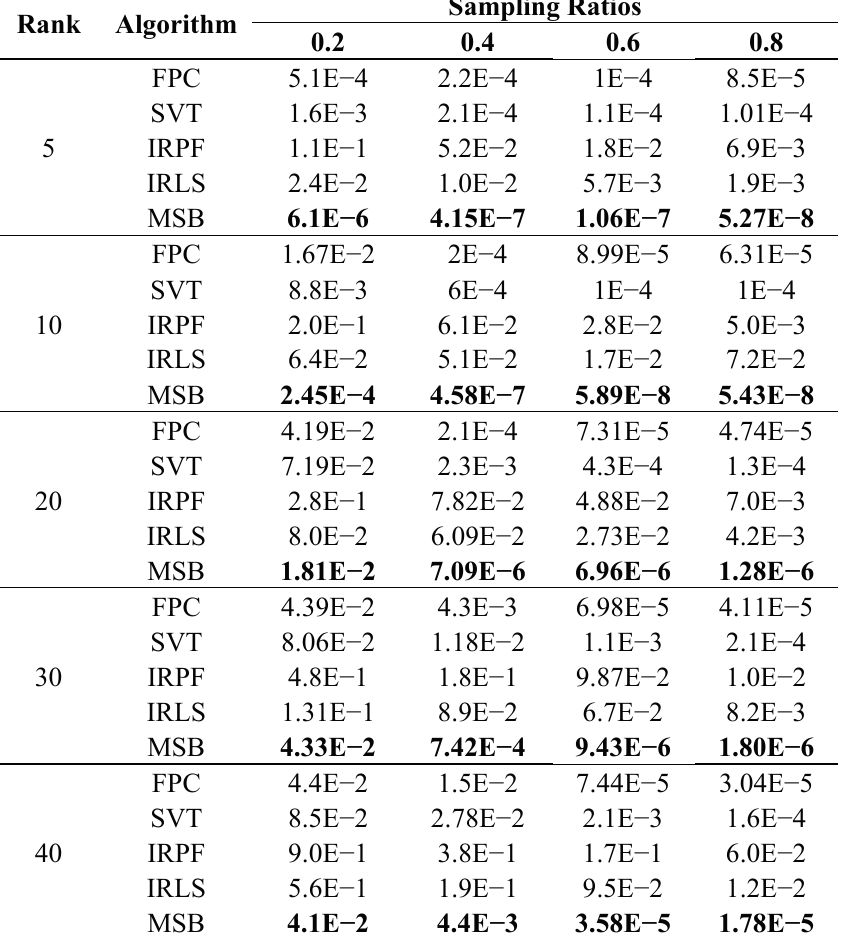
Table 2. NMSE for different